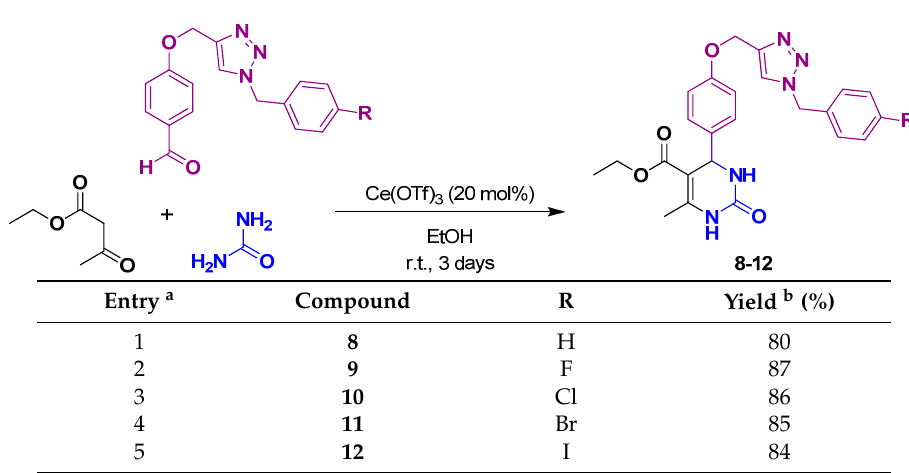
Table 2. Biginelli reaction catalyzed by Ce(OTf) 3 .